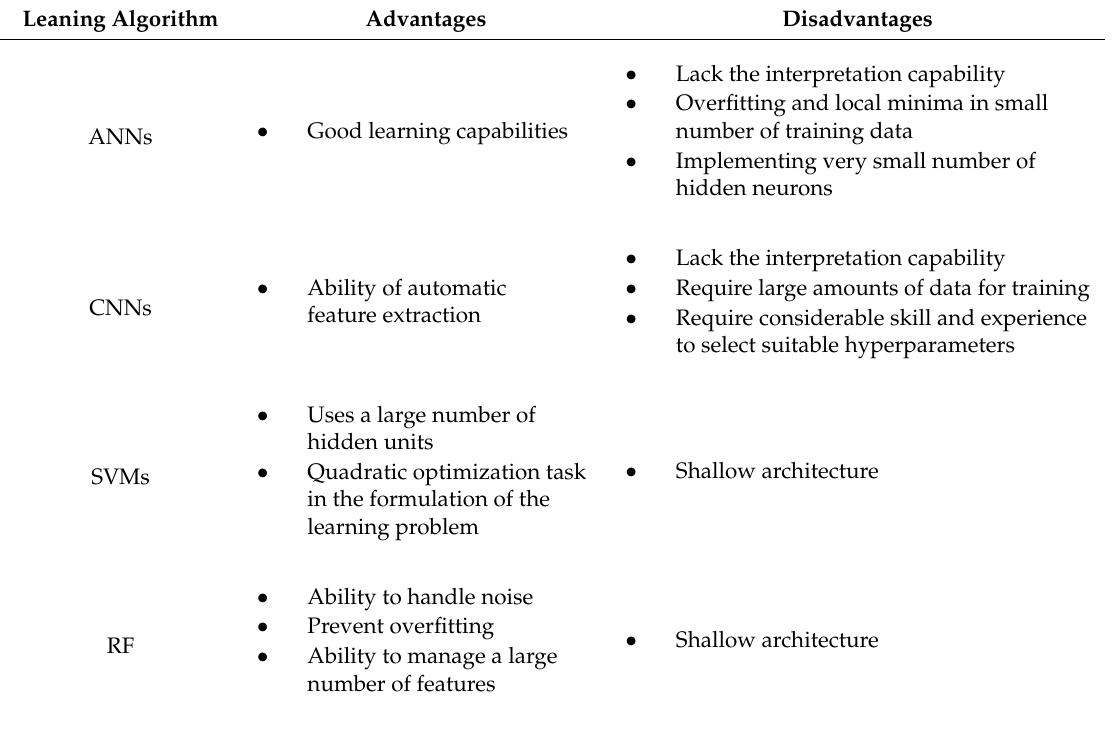
Table 1. Pros and cons of nonlinear machine learning algorithms applied in classical and in vitro-based plant breeding